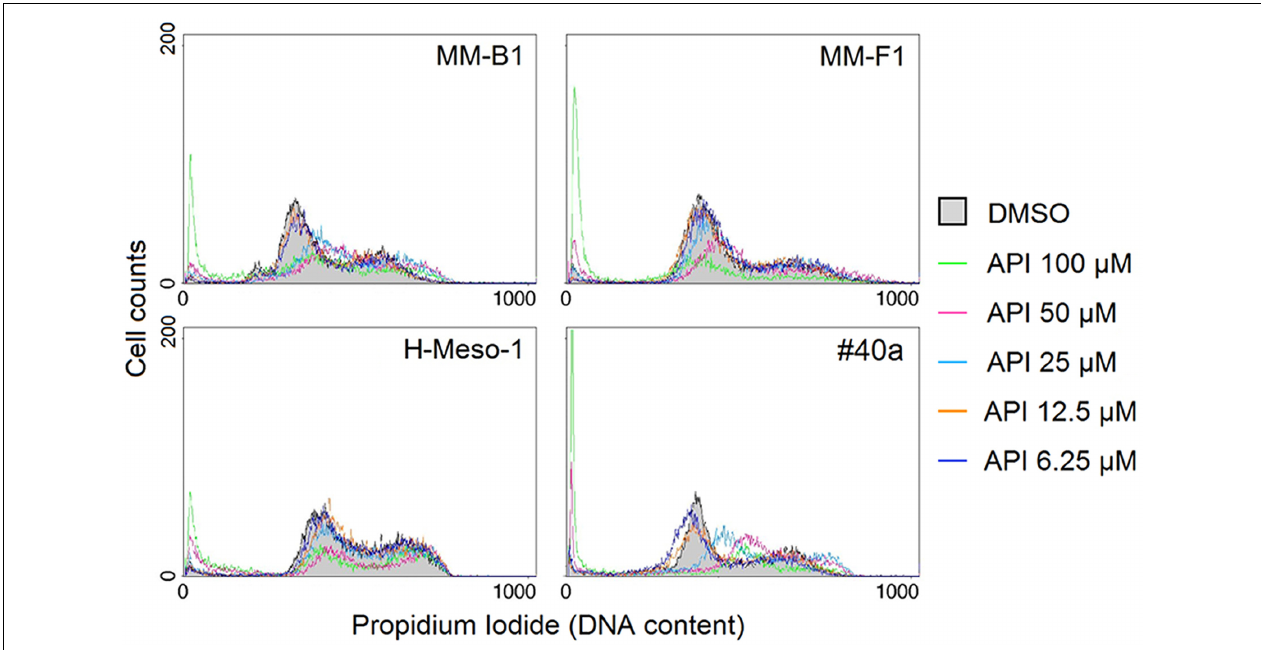
FIGURE 6 | Effect of API on cell cycle distribution. FACS analysis of DNA content was performed on asynchronized log phase growing MM cells treated for 48 hours with DMSO or API at 6.25–100 µ M. A representative experiment is shown in the figure.